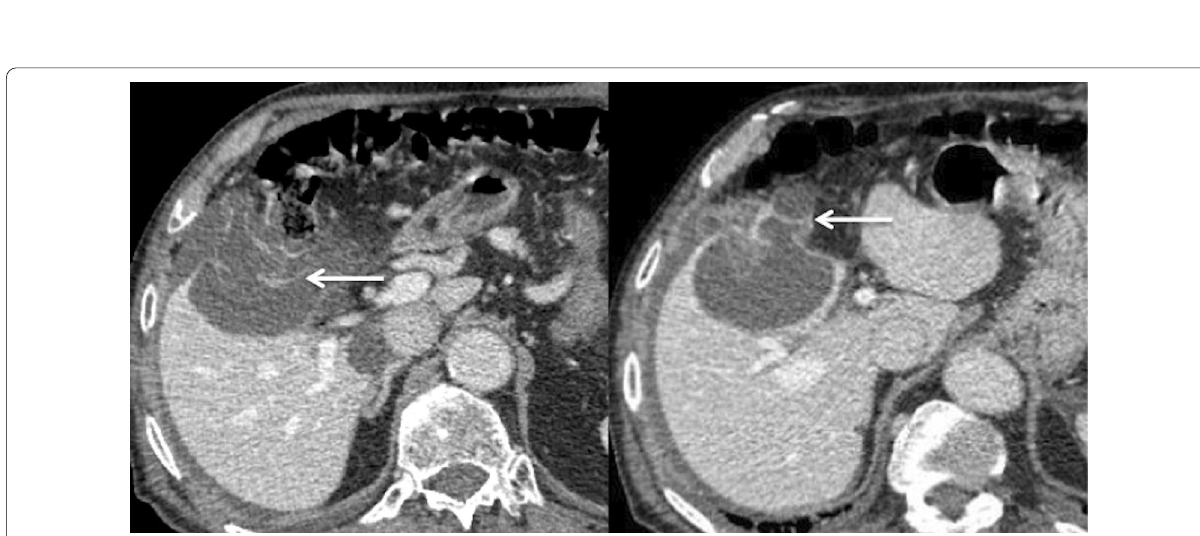
Fig. 8 Rupture of a hepatic cyst in a 89-year-old male with severe abdominal pain. Axial computed tomography on portal venous phase demonstrates a floating wall (arrow) associated with pericystic and peri-hepatic fluid